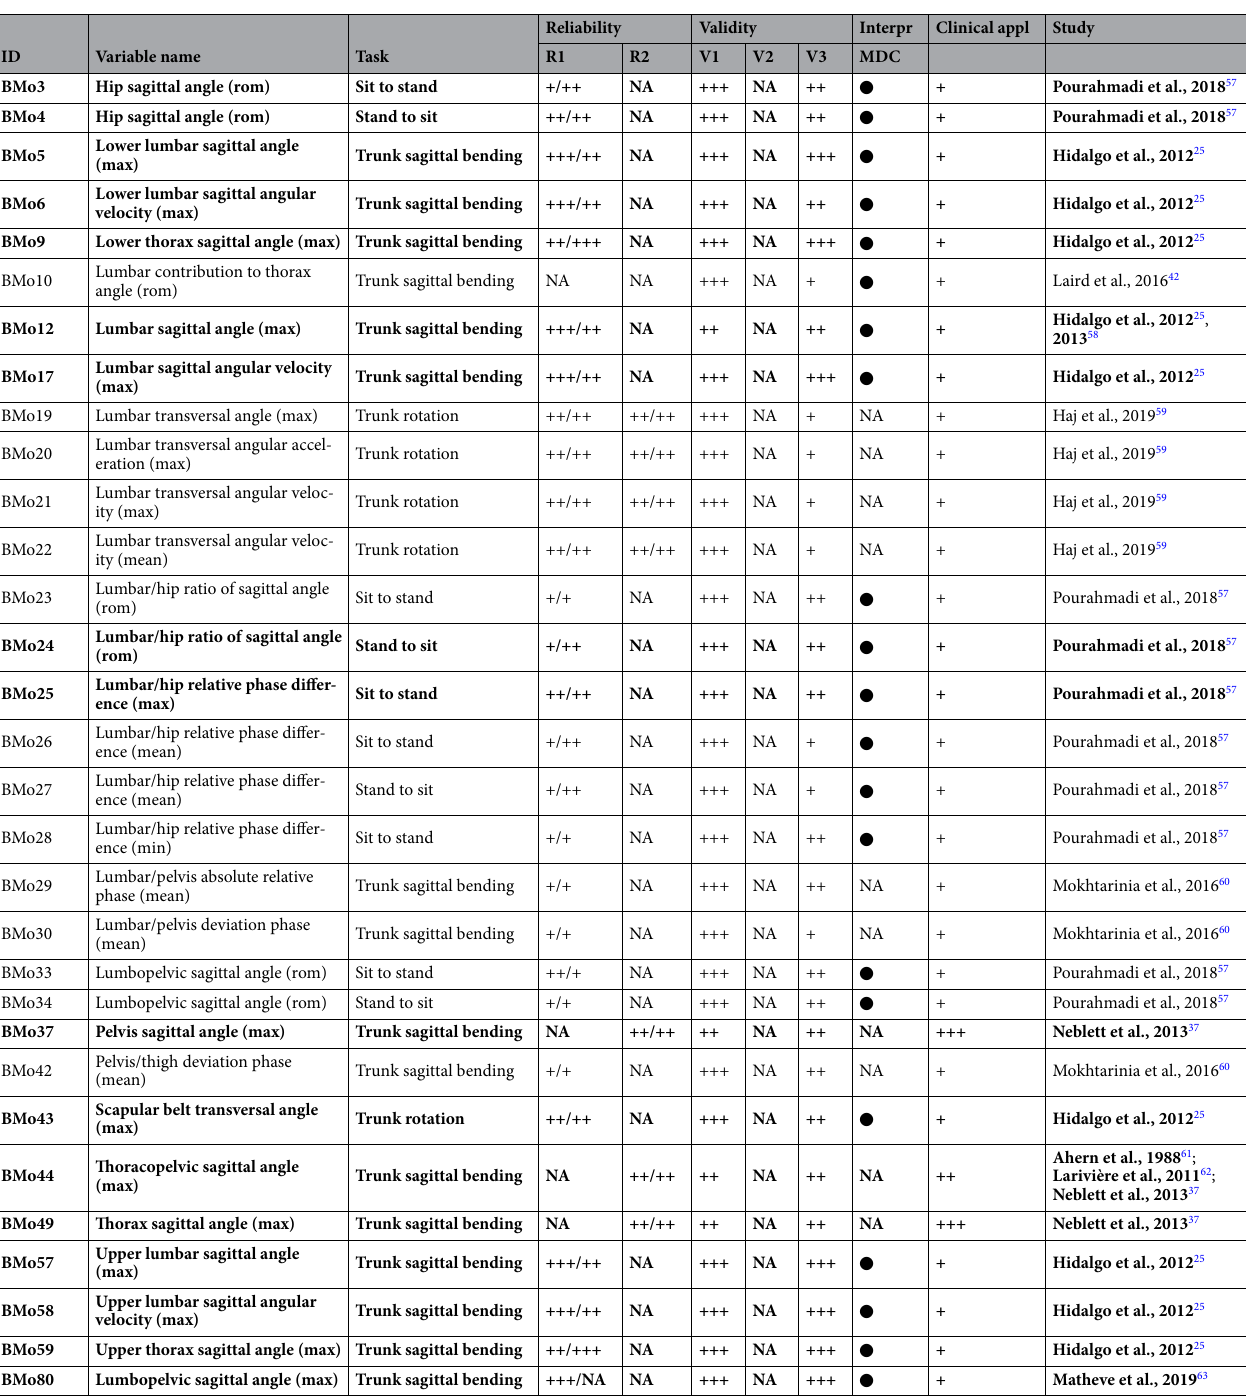
Table 1. List of movement biomarkers having at least 3 COSMIN items assessed in the included studies. Biomarkers for which all these items reached at least a good level (see Table 4 for measurement properties rating) are in bold. R1: Intra-observer reliability (controls/patients); R2: Inter-observer reliability (controls/patients); V1: Content validity; V2: Criterion validity; V3: Construct validity, rom: range of motion, max: maximum. min: minimum, MDC: minimum detectable change, interp.: interpretability, appl.: applicability, in bold: biomarkers for which all items reached at least a good level (see Table 1 for measurement properties rating). +++: Excellent; ++: Good; +: Moderate; : available; NA: not available (see Table 4 for measurement properties ●